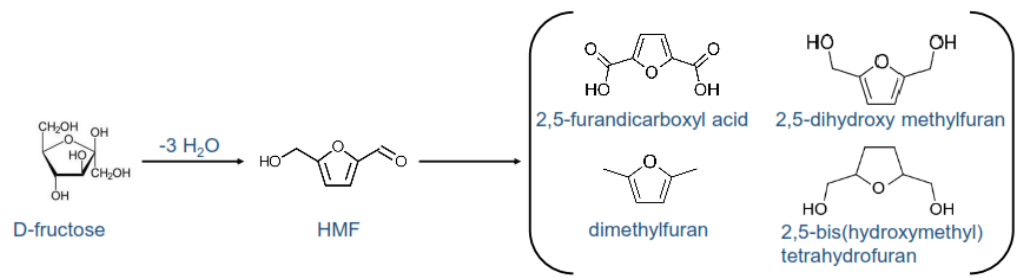
Figure 10. The obtained 5-HMF as an intermediate from carbohydrates to produce biofuel and value-added chemicals [69].